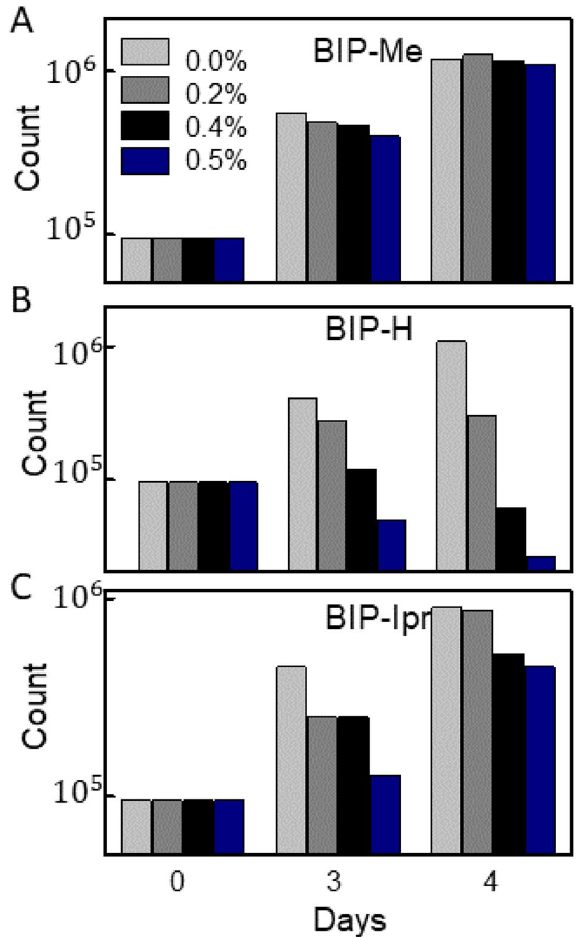
Figure 6. Cells counted over time show cytotoxicity results for ( A ) BIP-Me, ( B ) BIP-H and ( C ) BIP-IPr ligands taken over several days for different ligand concentrations by